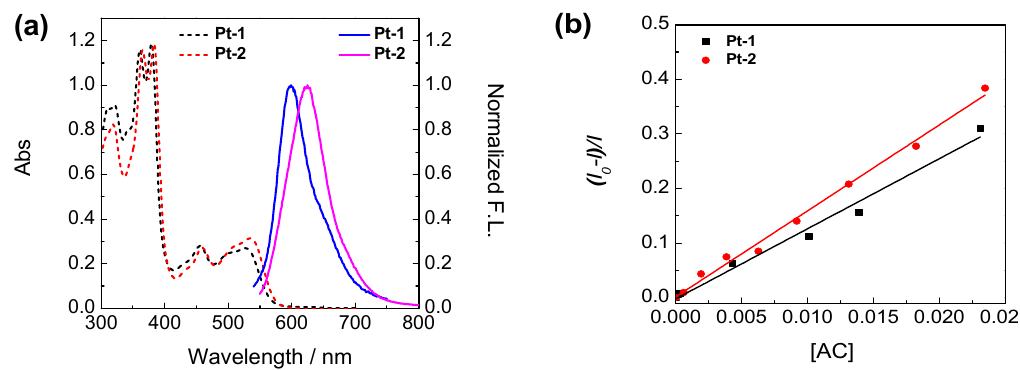
Figure 1. ( a ) Ultraviolet-visible (UV-vis) absorption spectra (dotted line) and normalized emission spectra (solid line) of Pt-1 and Pt-2, C = 5 × 10 − 5 M, 20 ◦ C. ( b ) Stern-Volmer Plots of ( I 0 − I ) / I versus [AC] in deaerated water, C [ Pt-1 , Pt-2 ] = 5 × 10 − 5 M, C [AC] = 0 − 2.31 × 10 − 5 M, 20 ◦